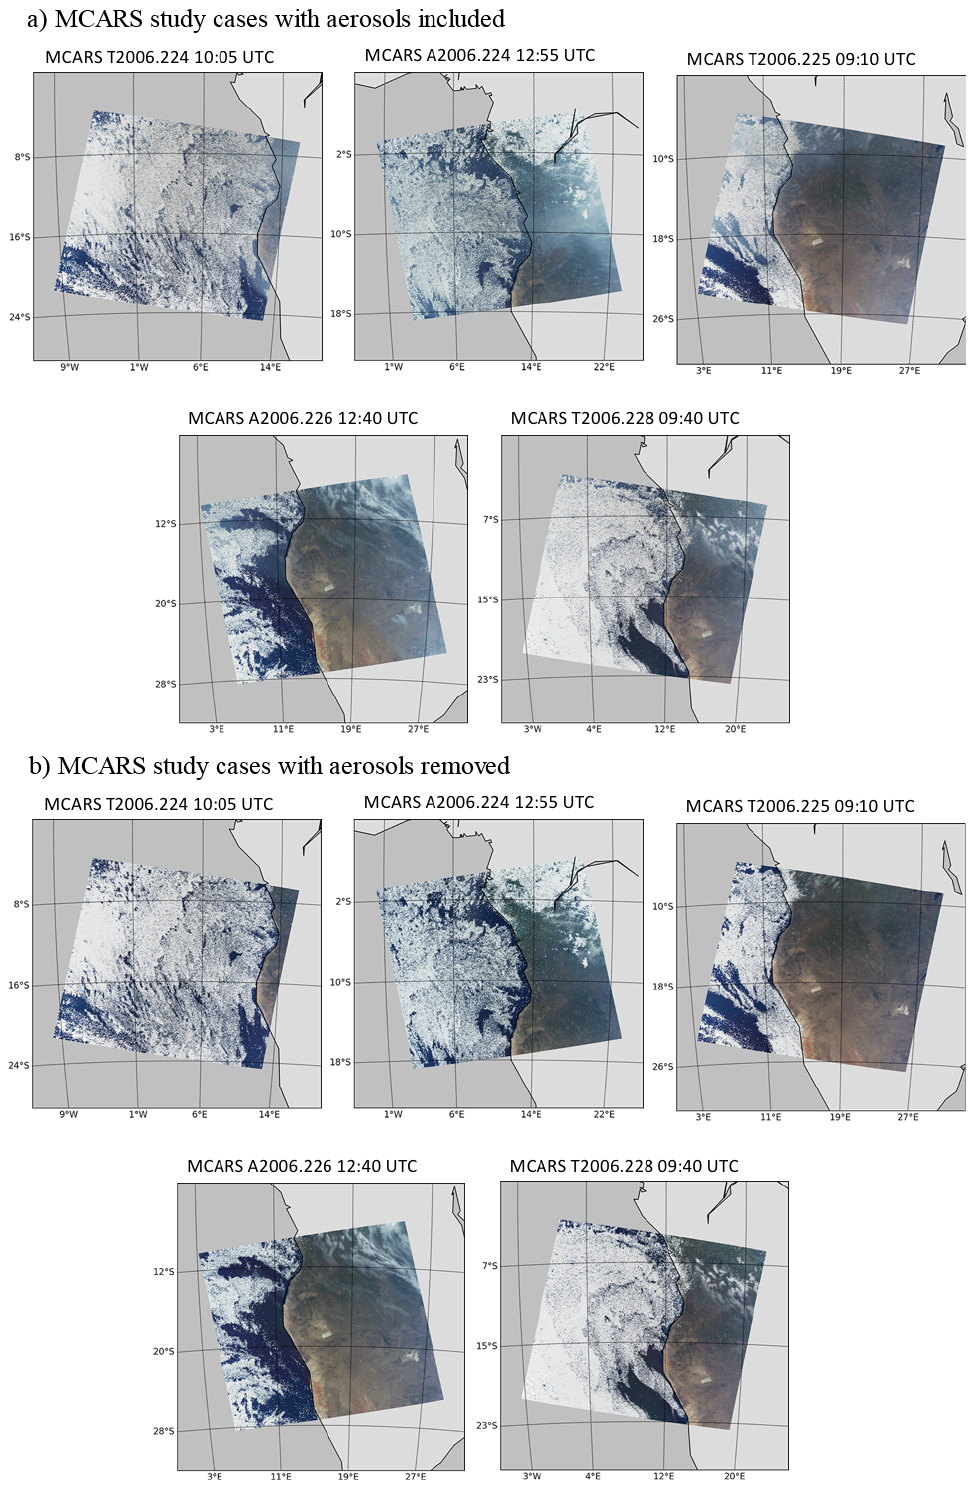
Figure 3. Scenes generated by MCARS from G5NR used in analysis of the MOD06ACAERO product. There are three cases based on Terra MODIS, designated with a T next to the year. There are two cases based on Aqua MODIS, designated with an A next to the year. Panel (a) shows the case set simulated with aerosols present. Panel (b) shows the same case set but simulated with aerosols removed.